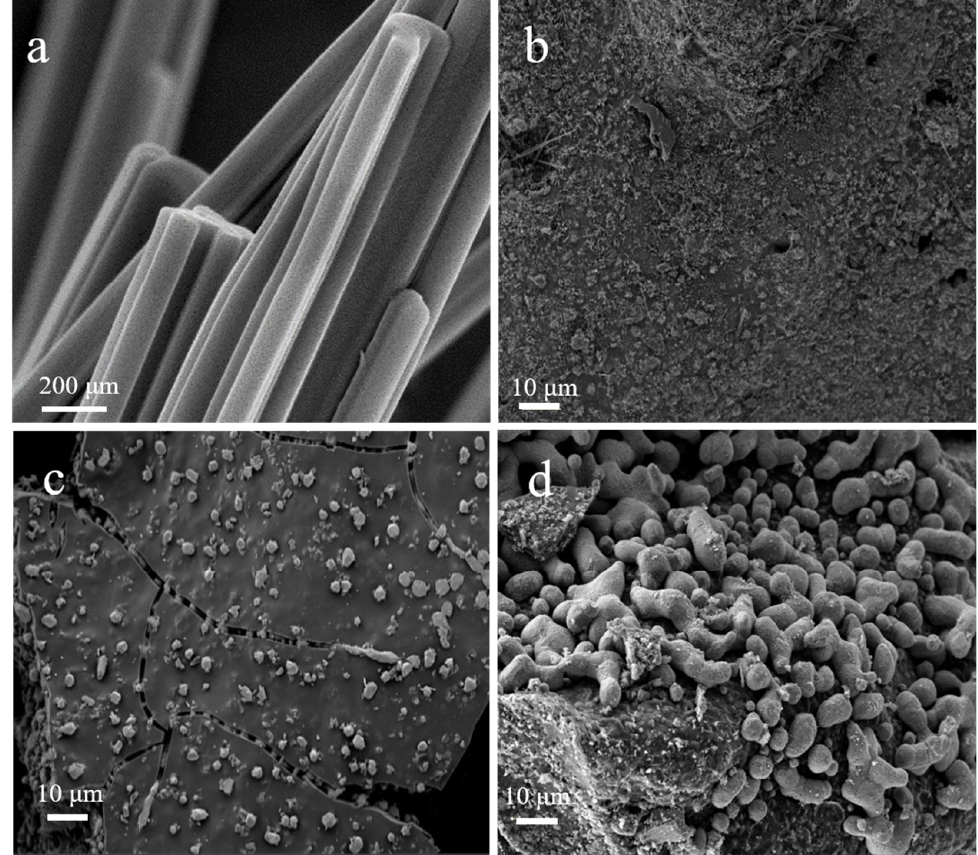
Figure 2. FE-SEM image of ( a ) Cu(im) 2 , ( b ) Cu@N-C(400), ( c ) Cu@N-C(600), and ( d ) Cu@N-C(800).